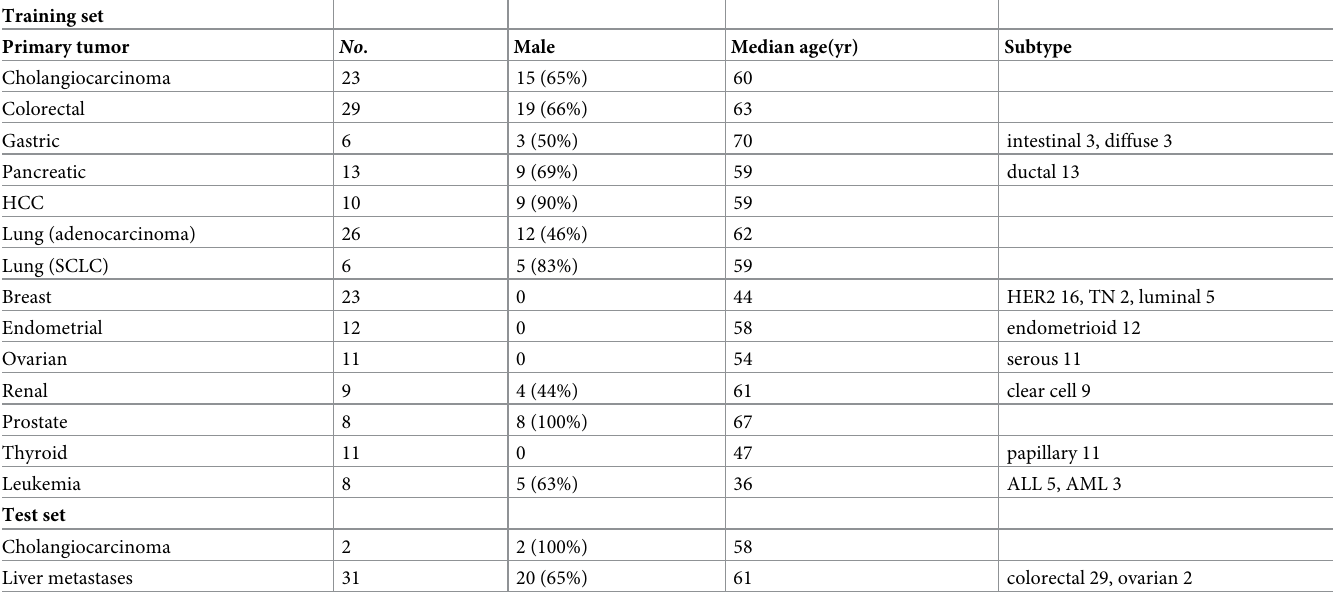
Table 1. Clinicopathological characteristics of tumor